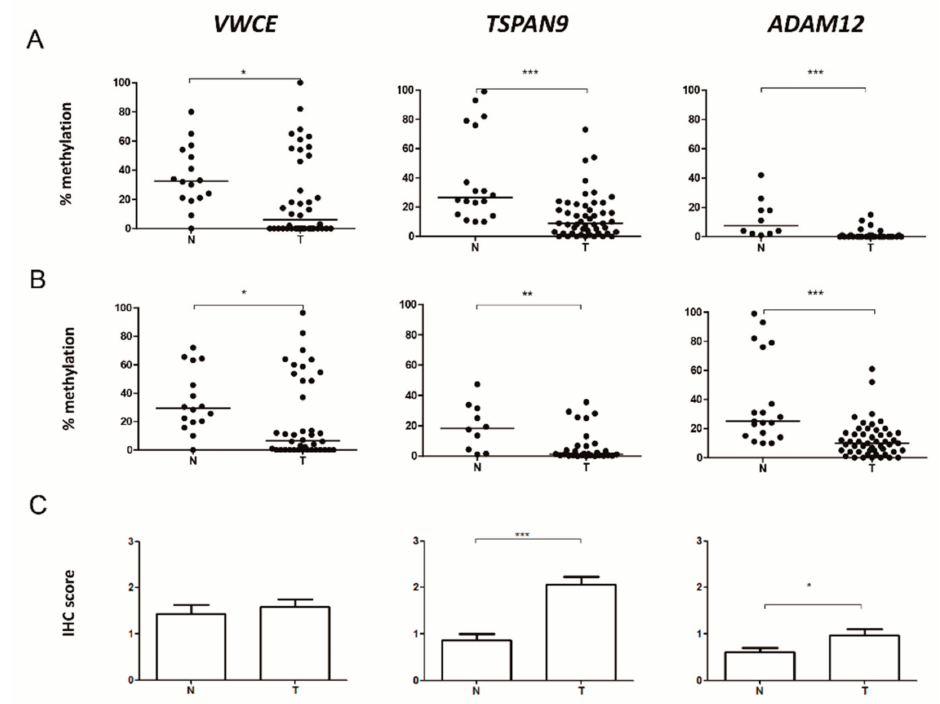
Figure 2. Methylation and protein levels of Von Willenbrand factor C and Epidermal Growth Factor domain-containing protein ( VWCE ), tetraspanin-9 ( TSPAN9 ) and disintegrin and metalloproteinase domain-containing protein 12 ( ADAM12 ) genes in breast tissues. ( A ) Methylation percentage of the CpG included in the array and ( B ) the mean of all the analysed CpGs in each gene exclusively hypomethylated in TNBC were measured by pyrosequencing in non-neoplastic breast (N) and TNBC (T) tissues. The horizontal lines represent the median of the series. ( C ) Levels of proteins encoded by those genes was determined by immunohistochemistry (IHC) in non-neoplastic samples (N) and TNBC (T). Expression was scored as: 0, no expression; 1, weak expression; 2, intermediate expression; and 3, strong expression. (*, p < 0.05; **, p < 0.01; ***, p < 0.001).